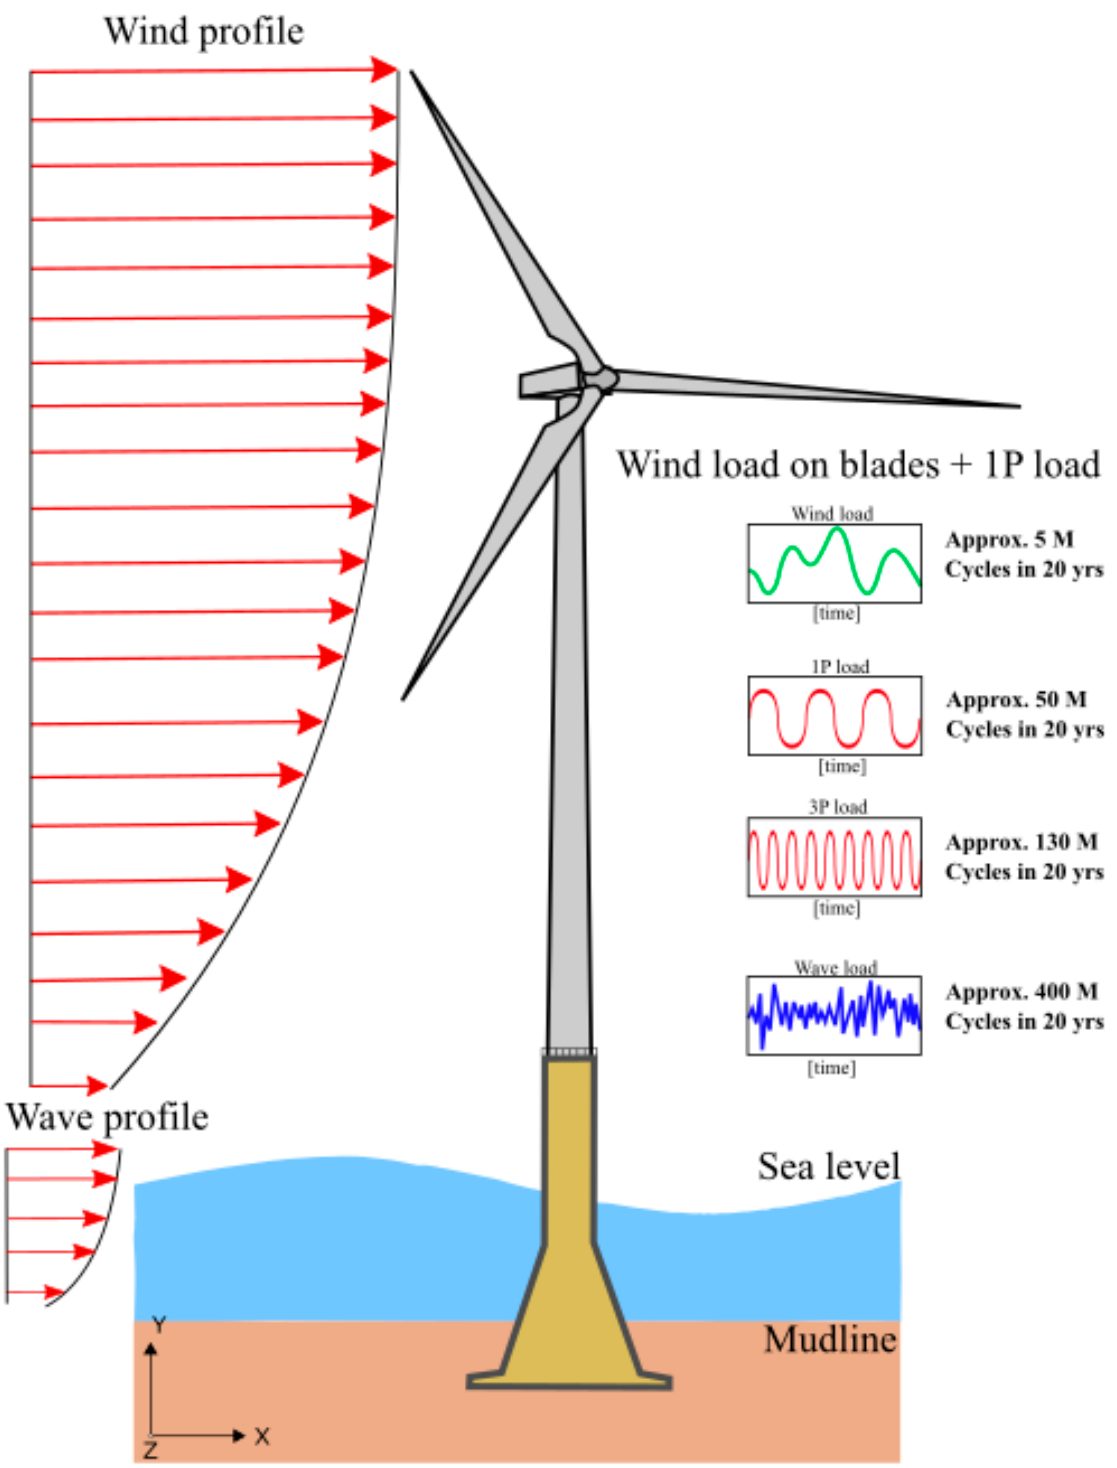
Figure 7. Load complexity with approximate number of cycles for 20 years assumed lifetime.